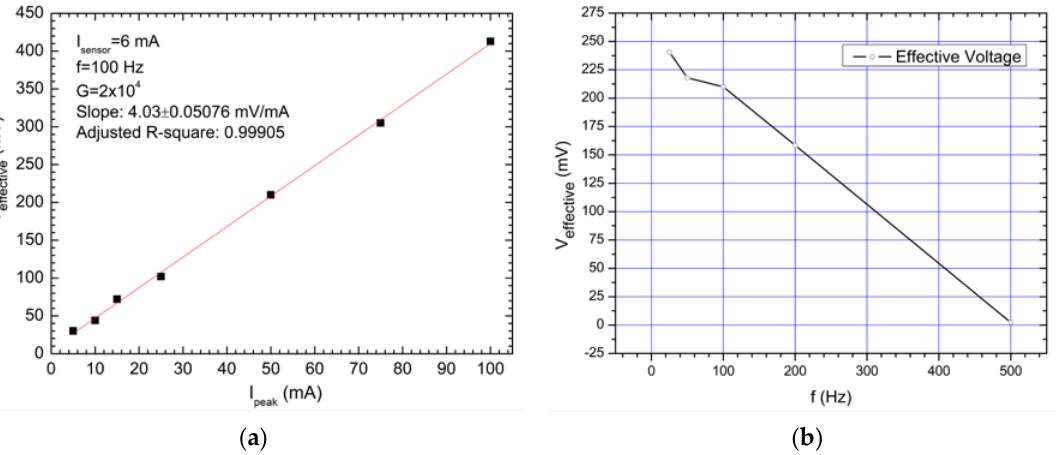
Figure 23. ( a ) AC calibration curve in the 0–100 mA range for a 100 Hz sinewave; ( b ) Frequency response of the output voltage for a 50 mA amplitude (peak-to-peak) sinewave.